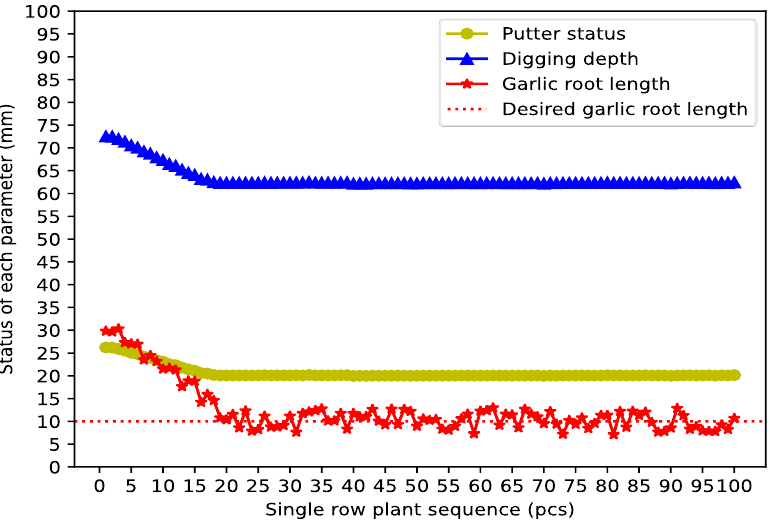
Figure 20. Variation of each parameter. The electric putter can adjust the digging depth to a reasonable position in time according to the error between the desired garlic root length and the actual garlic root length. The automatic depth limiting system was turned on and off for comparison, and the harvested garlic root length curves under these two conditions were plotted separately in Figure